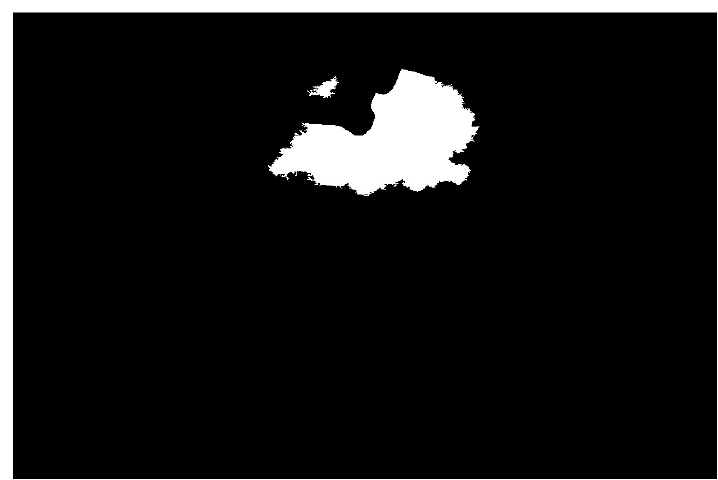
Figure 9. Binarized image: the image is a matrix of ones (white) and zeros (black). The flame front is